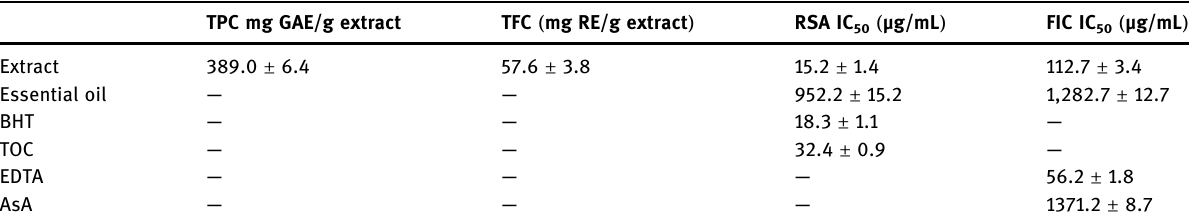
Table 2: TPC, TFC, DPPH RSA, and FIC of Equisetum arvense extract and essential